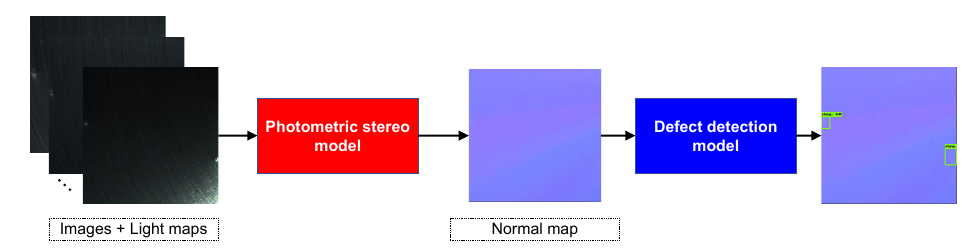
Figure 8. The framework of our detection model. The images captured under different illumination and the corresponding light information are used as input and the normal map is estimated through the photometric stereo model. The defect detection locates and classifies defects with the input of the normal map.